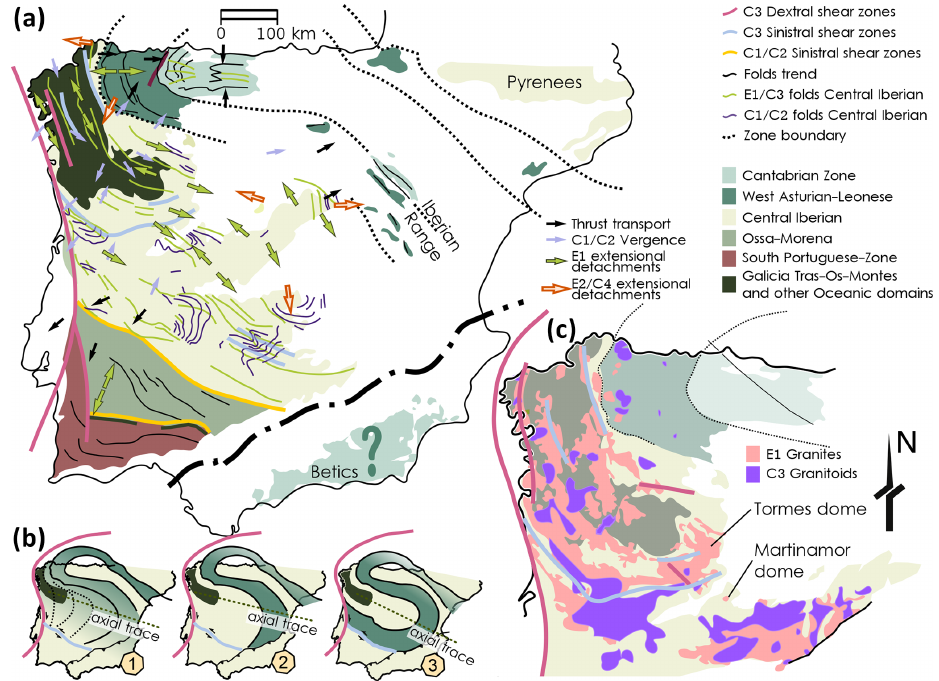
Figure 2. (a) Present-day configuration of the tectonostratigraphic zones of the Iberian Variscides and their major structures. White areas represent Mesozoic and Cenozoic cover. (b) Three competing geometric proposals for the Central Iberian curve: (1) a disharmonic curvature up to 160 ◦ at the outer arc but much less pronounced at the inner arc (Aerden, 2004); (2) a harmonic but more open curvature as suggested by Martínez Catalán (2012); (3) an isoclinal curvature model (Shaw et al., 2012). (c) Distribution of the E1 (migmatitic domes) and C3 to post-C3 granitoids in the NW of Iberia (modified from Pastor-Galán et al.,